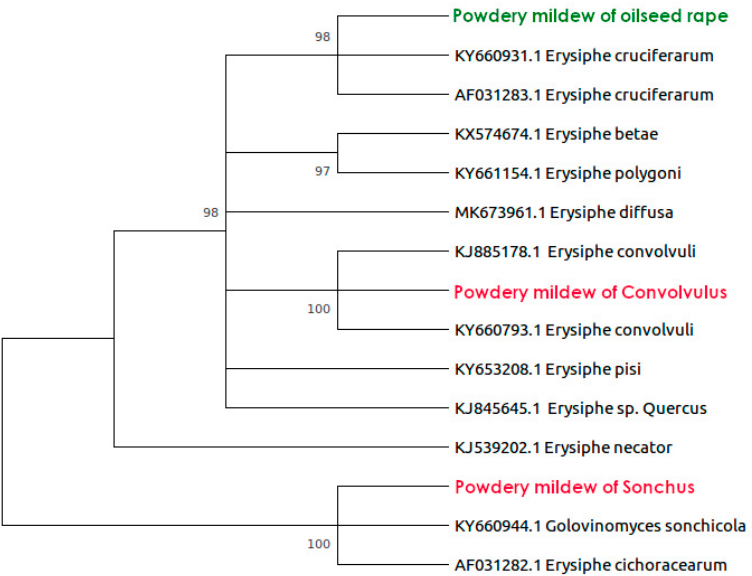
Figure 2. Phylogenetic maximum-likehood tree of E. crucifertaum, E. cichoracearum and E. convolvuli (highlighted in color). Bootstrap values >70% computed by 1000 replicates are given.